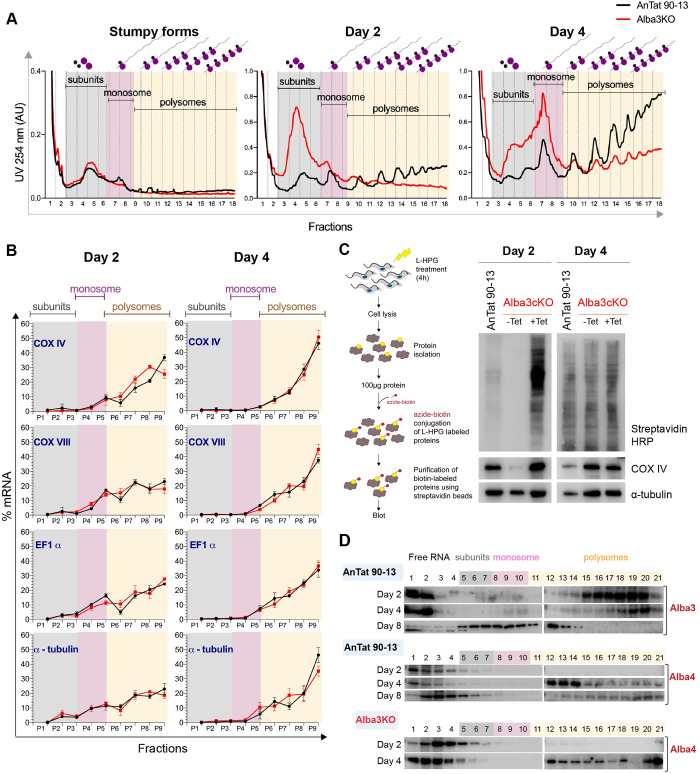
Polysome profiles and translation during differentiation.(A) Polysome profiles of AnTat 90–13 and Alba3KO cells harvested at day 0 (stumpy forms), day 2 and 4 of differentiation. Cell lysates were overlaid on 10–50% sucrose gradients and subjected to ultracentrifugation. Gradients were collected from top (fraction 1) to bottom (fraction 18) while continuously monitoring UV absorbance at 254nm to determine the concentration of RNA. For technical reasons (see Materials and Methods) 3-fold fewer cell equivalents were loaded for stumpy forms of both cell lines. The figure is a representative example of one of three biological replicates. (B) Distribution of mRNAs for COX IV, COX VIII, EF1a and α-tubulin determined by RT-qPCR. Total RNA was extracted from the sucrose gradient fractions in (A). Pairs of consecutive fractions were pooled (e.g. fractions 1 and 2) giving rise to RNA fractions P1-P9. The distribution of mRNA is shown as the percentage of total mRNA (% mRNA) in each fraction. Error bars, mean ±SD of 3 technical replicates. (C) Analysis of newly synthesised proteins in AnTat 90–13 and Alba3cKO on day 2 and day 4 of differentiation. Ectopic Alba3 expression was induced (+Tet) or not (-Tet) by addition of tetracycline. Left; Diagram illustrating the experimental procedure. Right; Western blot analysis. Newly synthesised proteins were detected using streptavidin-HRP. Newly synthesised COX IV and α-tubulin proteins were detected using specific antibodies. (D) Distribution of Alba3 and Alba4 proteins over the sucrose gradients. The upper and middle panels represent the Western blot analyses of Alba3 and Alba4, respectively, in sucrose gradient fractions obtained from the parental line AnTat 90–13 on days 2, 4 and 8 of differentiation. The lower panel represents Western blot analyses of Alba4 in fractions obtained from Alba3KO on days 2 and 4. The condition of these cells by day 8 precluded any analyses.